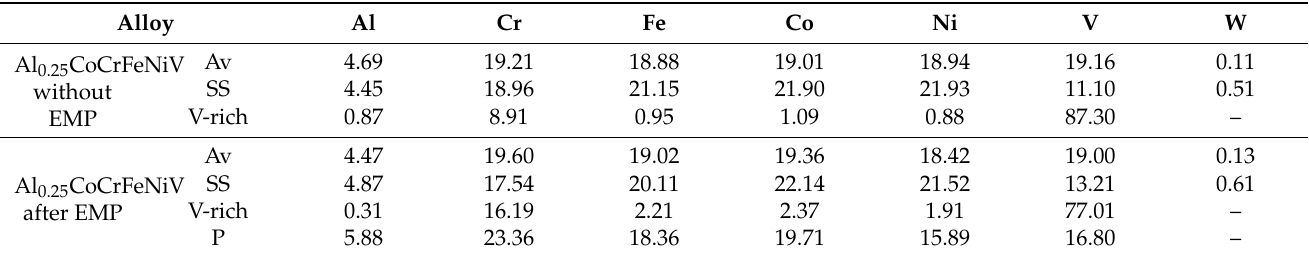
Figure 4. EDS mapping for Al 0.25 CoCrFeNiV alloy, ( a ) without the EMP and ( b ) after the EMP. Table 1. EDS chemical composition of samples without and with the EMP (at.%). Av—average composition; SS—solid solution; V-rich—saturated V phase; P—precipitate in solid solution (see Figure